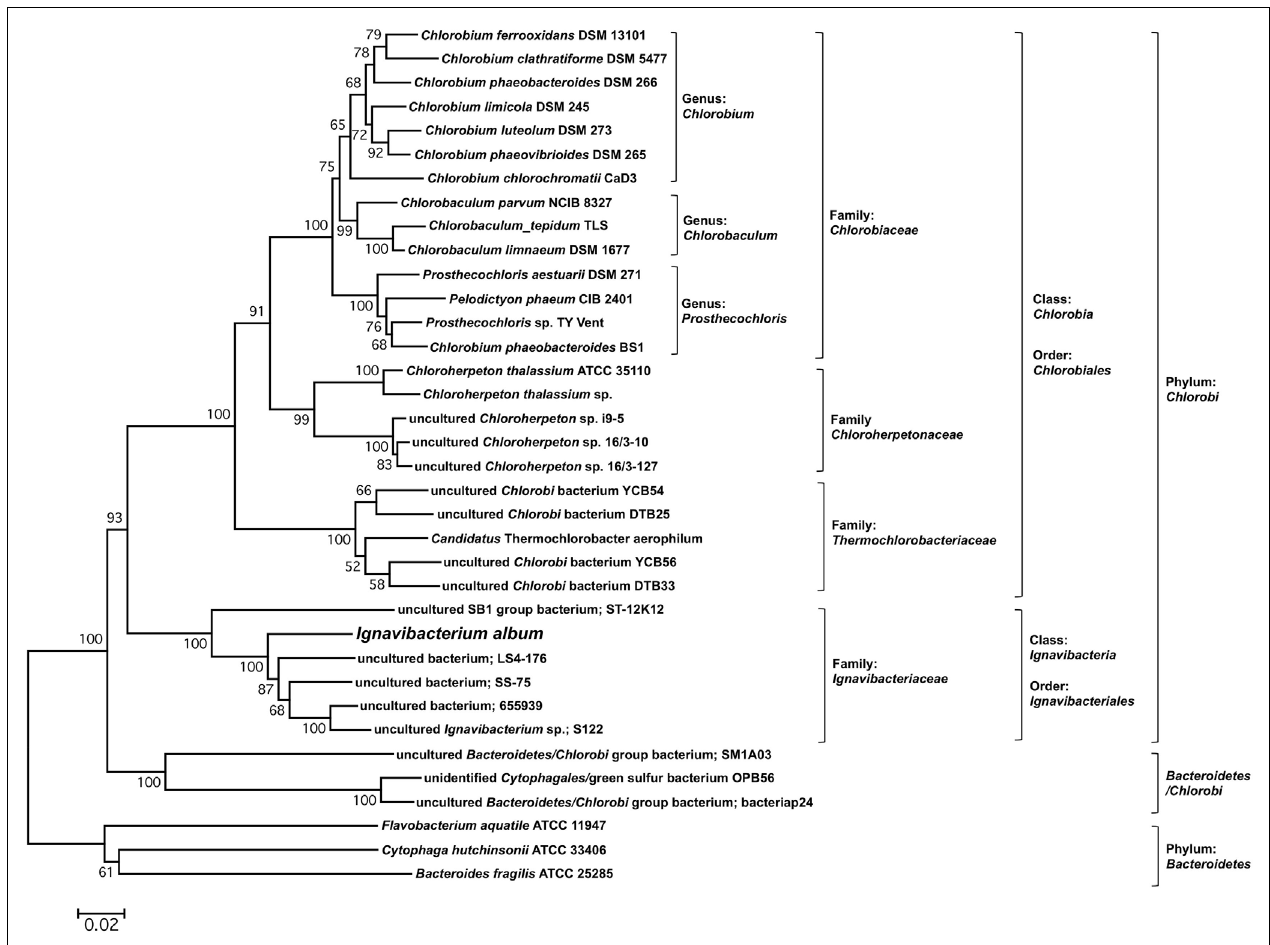
based on 1000 bootstrap samplings were shown for each node. Bar denotes 0.02 changes per nucleotide site.The classes Chlorobia and Ignavibacteria only contain one order and brackets for those orders were omitted to simplify the